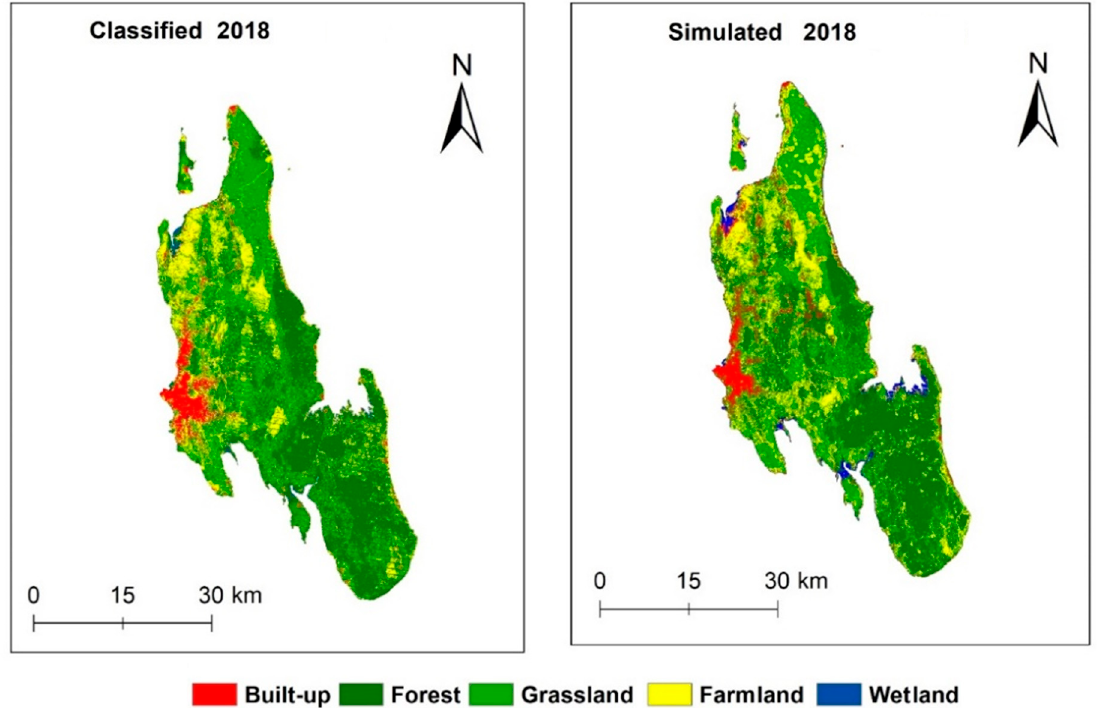
Figure 7. Land cover maps for 2018 actual ( left ) and simulated ( right ).